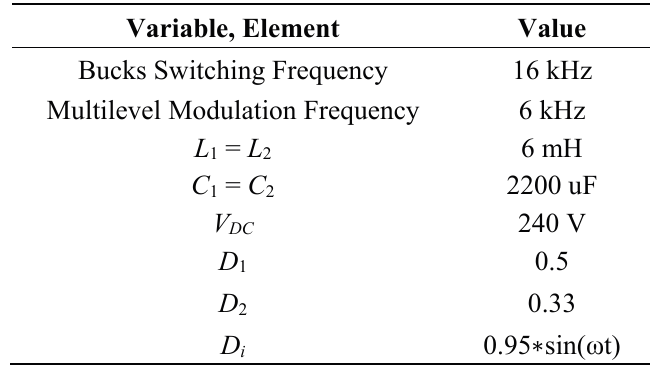
Table 4. Parameter values for the simulation of the proposed